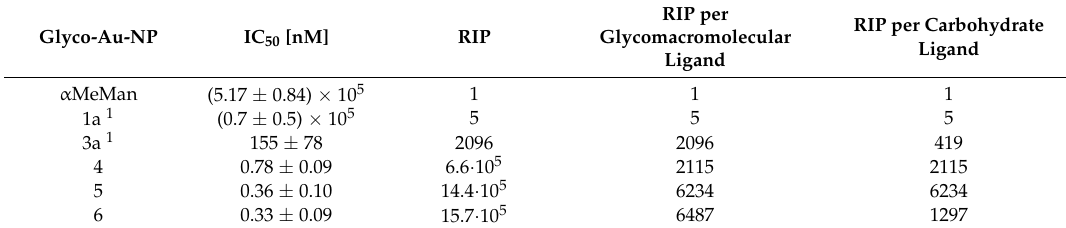
Table 4. IC 50 and RIP values as measured for glyco-AuNPs 4 – 6 and N -ethylmaleimide capped glycomacromolecules 1a and 3a by SPR and derived RIP values corrected for glycomacromolecule and carbohydrate number per nanoparticle.